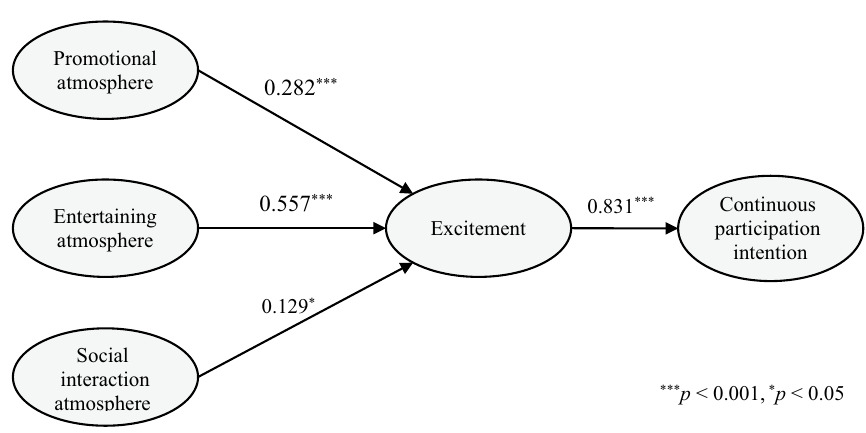
Fig. 2 Structure model. χ 2 RMR 0.047, RMSEA =